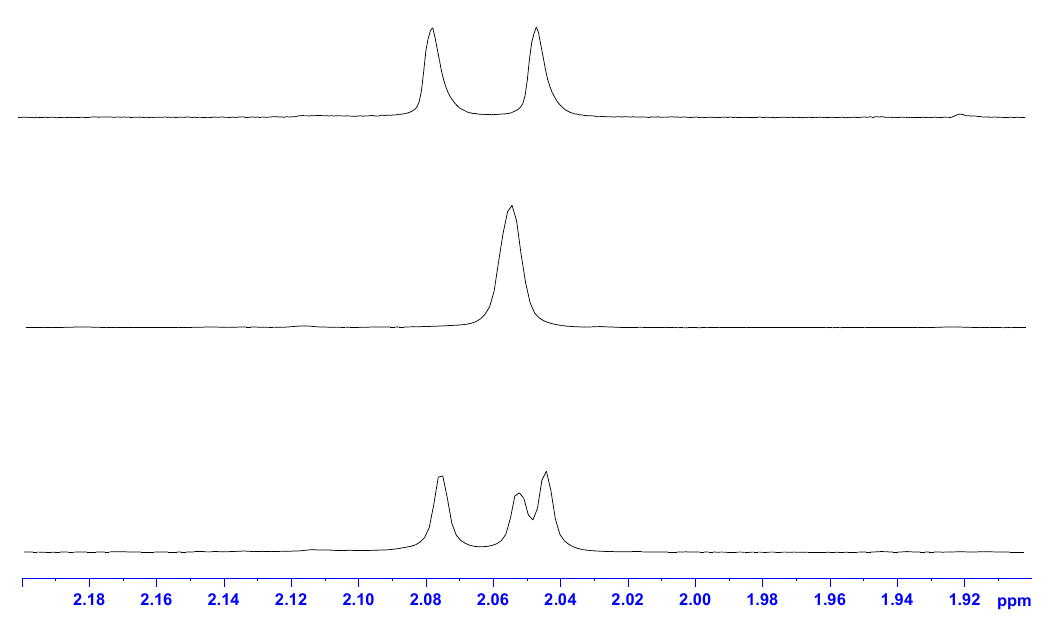
Figure 1. 1 H-NMR spectroscopy of N -acetyl group of GlcNAc, (GlcNAc) hydrolyzates of chitin by chitinase at 290 K.